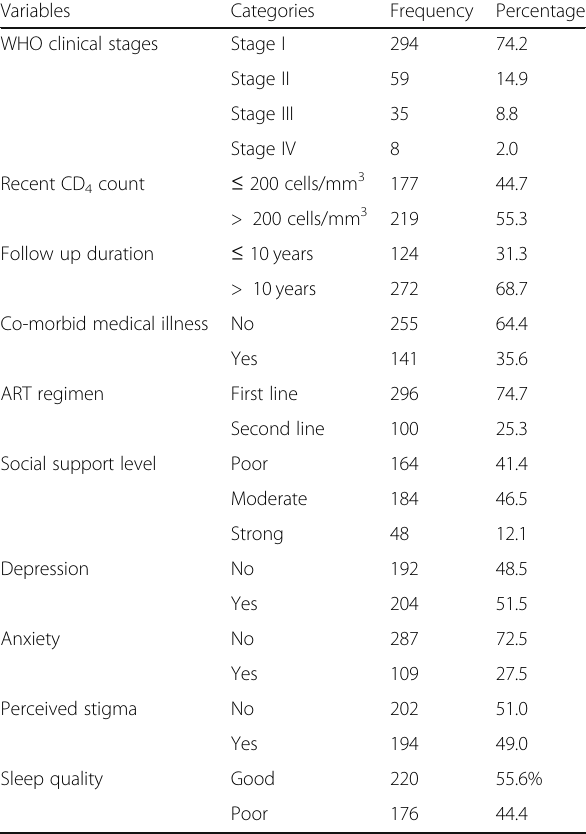
Table 2 Clinical and psycho-social characteristics of people with HIV/AIDS attending ART follow-up at Zewditu Memorial Hospital, Addis Ababa, Ethiopia, 2018 ( n = 396) Variables